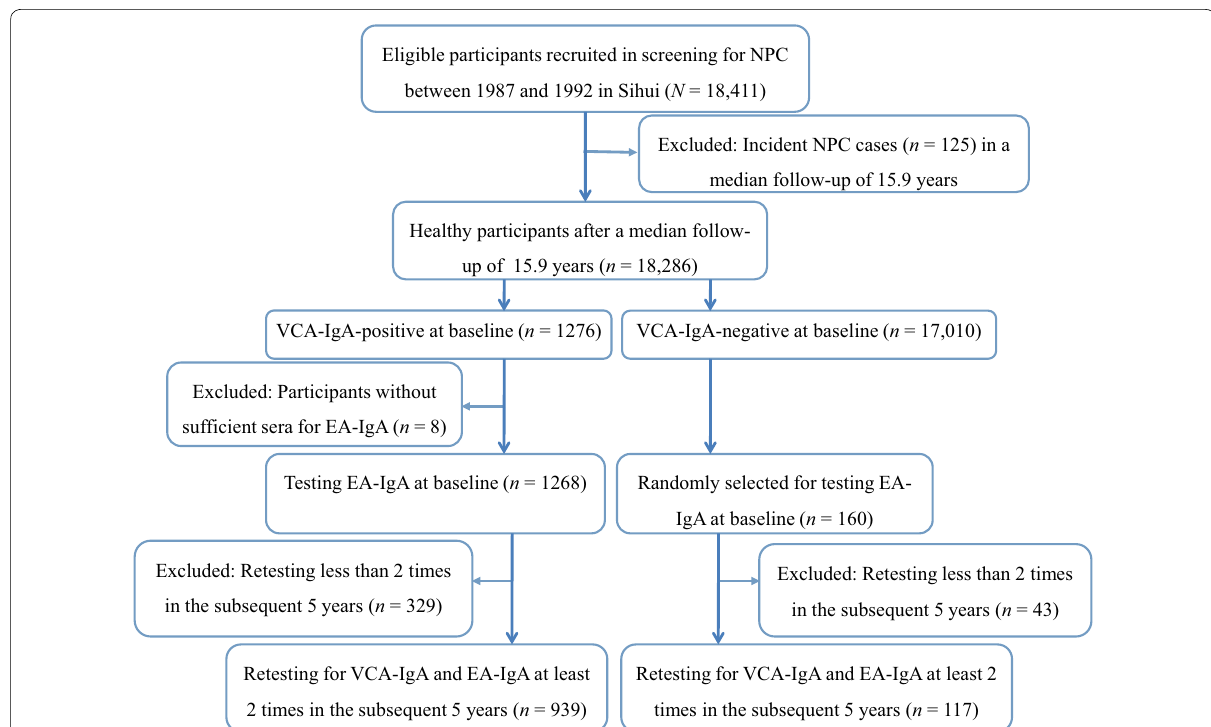
Fig. 1 Recruitment diagram of the non‑nasopharyngeal carcinoma (NPC) population for the analysis of the long‑term variation trends of serum Epstein–Barr virus (EBV) antibodies. VCA-IgA immunoglobulin A (IgA) antibody against EBV viral capsid antigen; EA-IgA IgA antibody against EBV early